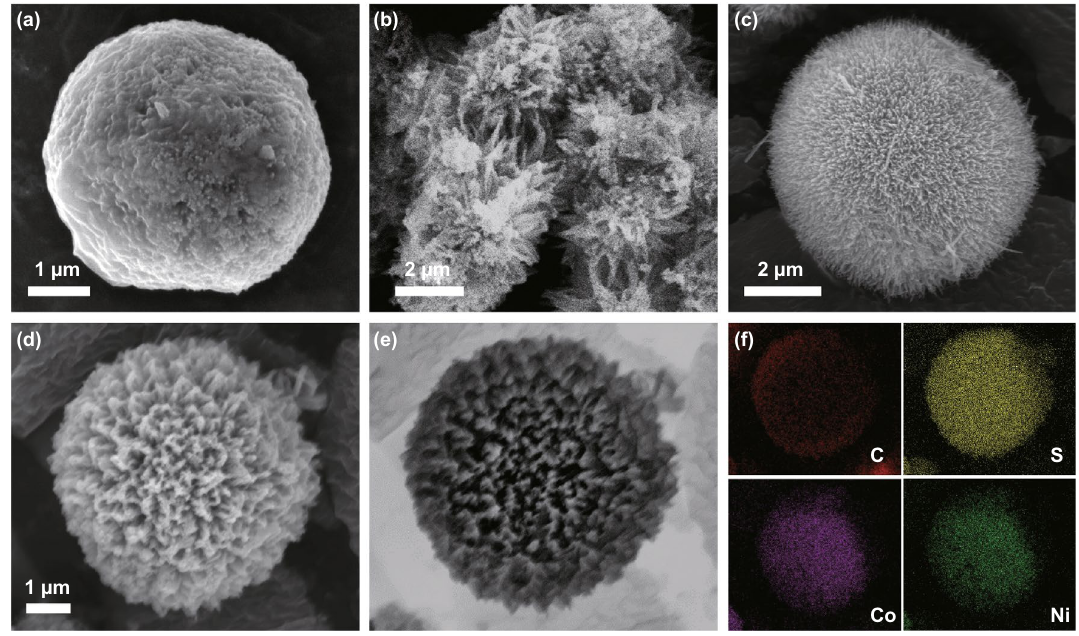
Fig. 2 SEM images of a pure MCMB after calcination, b pure NCS, c NCS@MCMB precursor, and d NCS@MCMB composite. e SEM back- scattered image of an individual NCS@MCMB sphere and f corresponding EDX elemental maps of C, S, Co, and